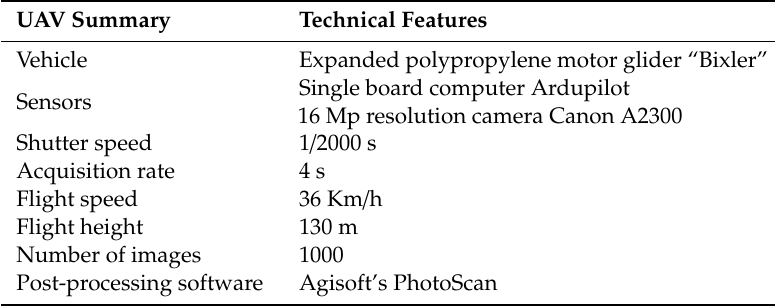
Table 3. Summary of unmanned aerial vehicles (UAV) survey